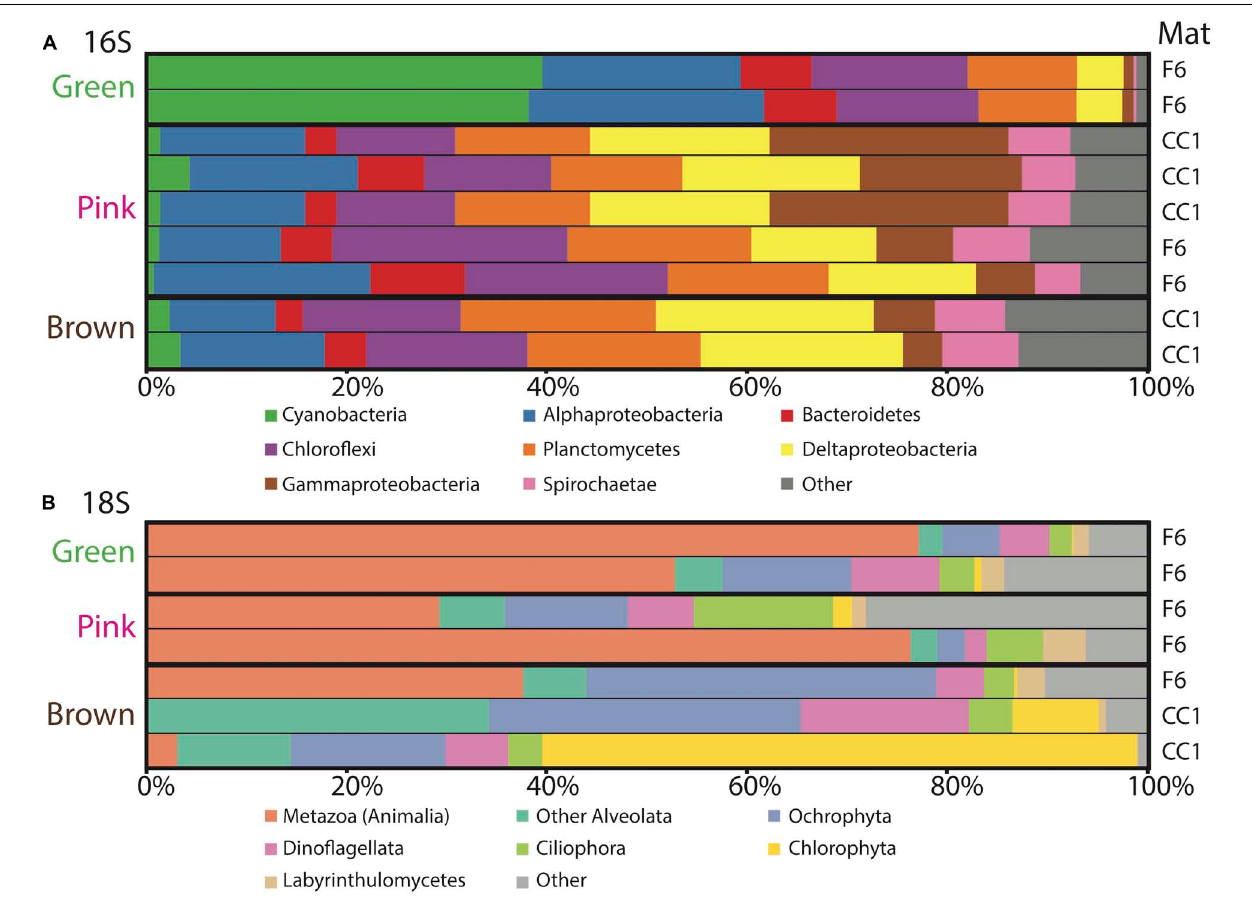
FIGURE 5 | Microbial diversity with depth in the green, pink and brown layers of polygonal mats CC1 and F6 recovered using iTag sequencing of the (A) 16S and (B) 18S rRNA genes. Relative abundances (%) do not include reads unassigned to any taxon. Operational taxonomic units assigned to families constituting a small percentage of total reads are labeled “other.” Mats sampled for the data are indicated on the